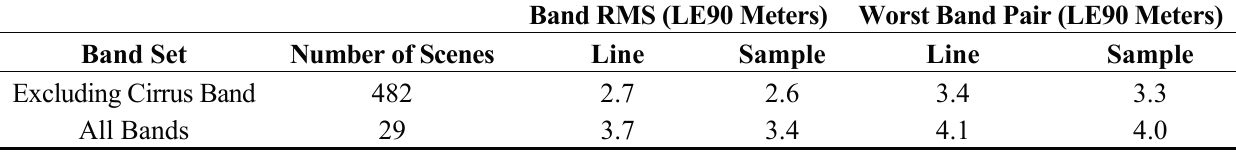
Table 5. OLI band registration accuracy, with and without the cirrus band. Both all-band average and worst case band-pair results are shown.